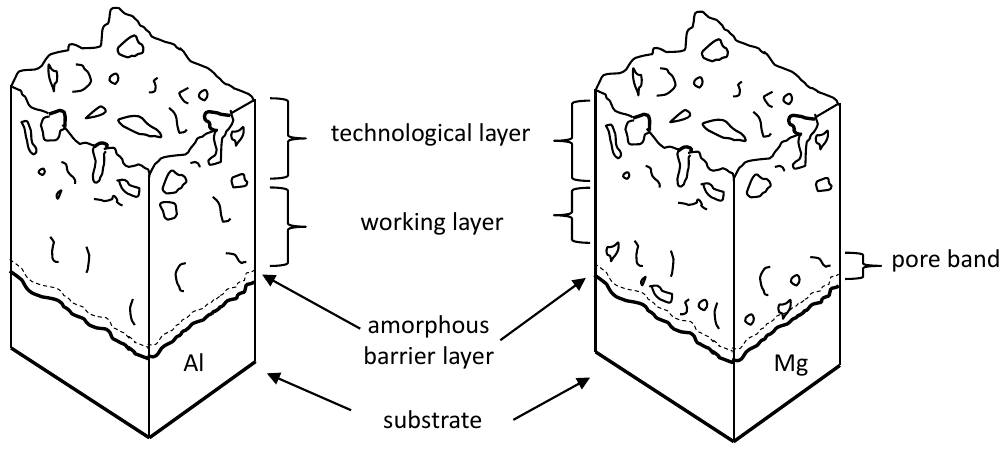
Figure 2. Schematic representation of the morphology of PEO layers on aluminium [25,26] ( left ) and magnesium materials within fluoride-free electrolyte [23,24] ( right